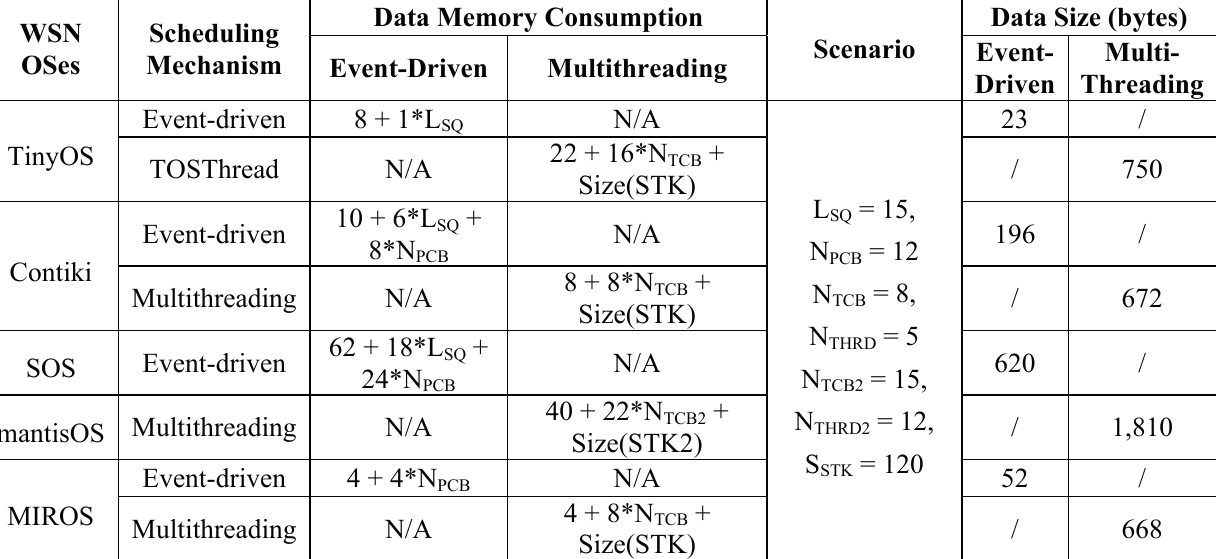
Table 1. Date memory cost of the event-driven and multithreaded schedulers in different OSes. WSN